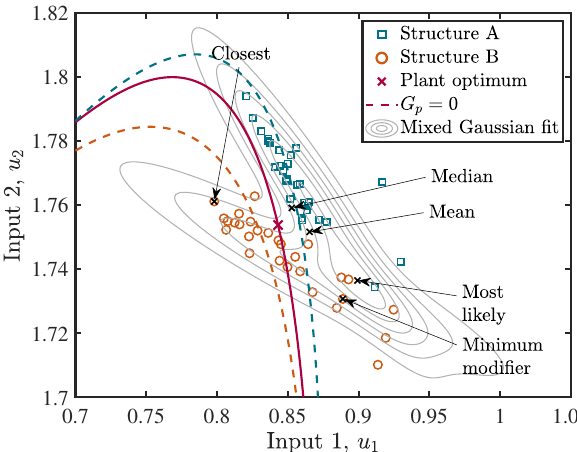
Figure 3. Example 2 processed solutions. The blue squares represent structure A, the orange circles represent structure B, dashed lines represent the nominal constraint, the red line represents G p = 0, the grey contour represents the mixed Gaussian fit, and the black crosses represent the solution processing for each of the proposed